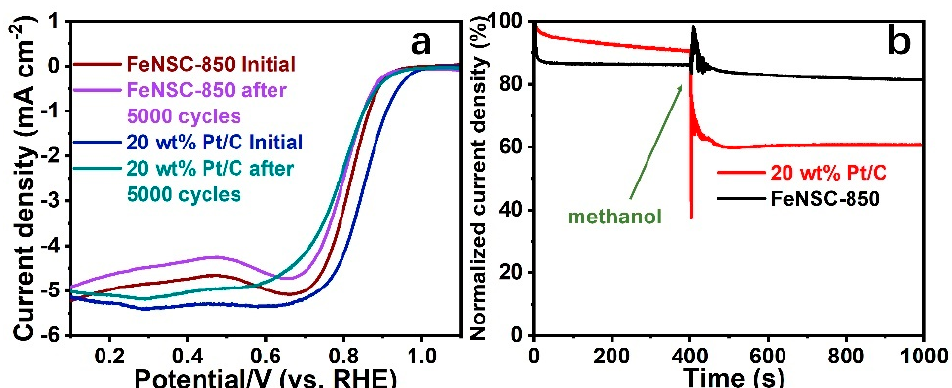
Figure 6. ( a ) LSV curves of FeNSC ‐ 850 at 1600 rpm with a scanning rate of 5 mV s − 1 before and after 5000 cycles in O 2 ‐ saturated 0.1 M KOH solution, ( b ) I ‐ t response of FeNSC ‐ 850 and commercial Pt/C 5000 cycles in O 2 -saturated 0.1 M KOH solution, ( b ) I-t response of FeNSC-850 and commercial Pt/C with the injection of methanol at ~400s in O 2 ‐ saturated 0.1 M KOH electrolyte. with the injection of methanol at ~400s in O 2 -saturated 0.1 M KOH electrolyte. Table 2. Comparison of ORR performances of FeNSC-850 with some representative reports in 0.1 M KOH